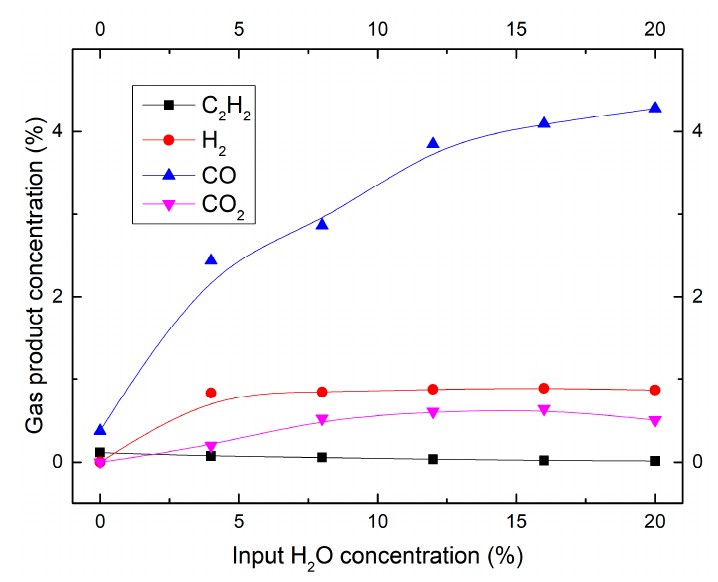
Figure 8. Effect of moisture concentration on the composition of the off-gas.